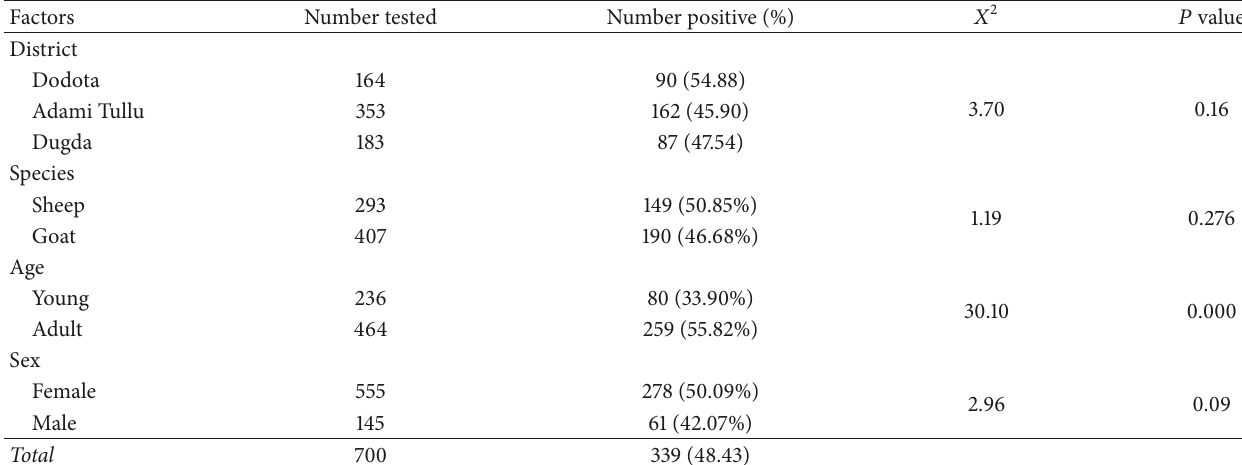
Table 1: Seroprevalence of PPR in sheep and goats from study